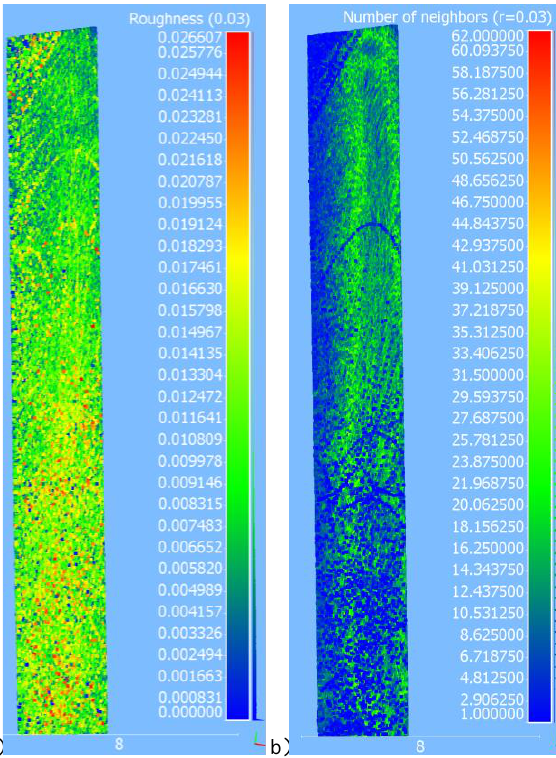
Figure 7. Roughness (a) and number of neighbours (b) calculated for the Livox Avia